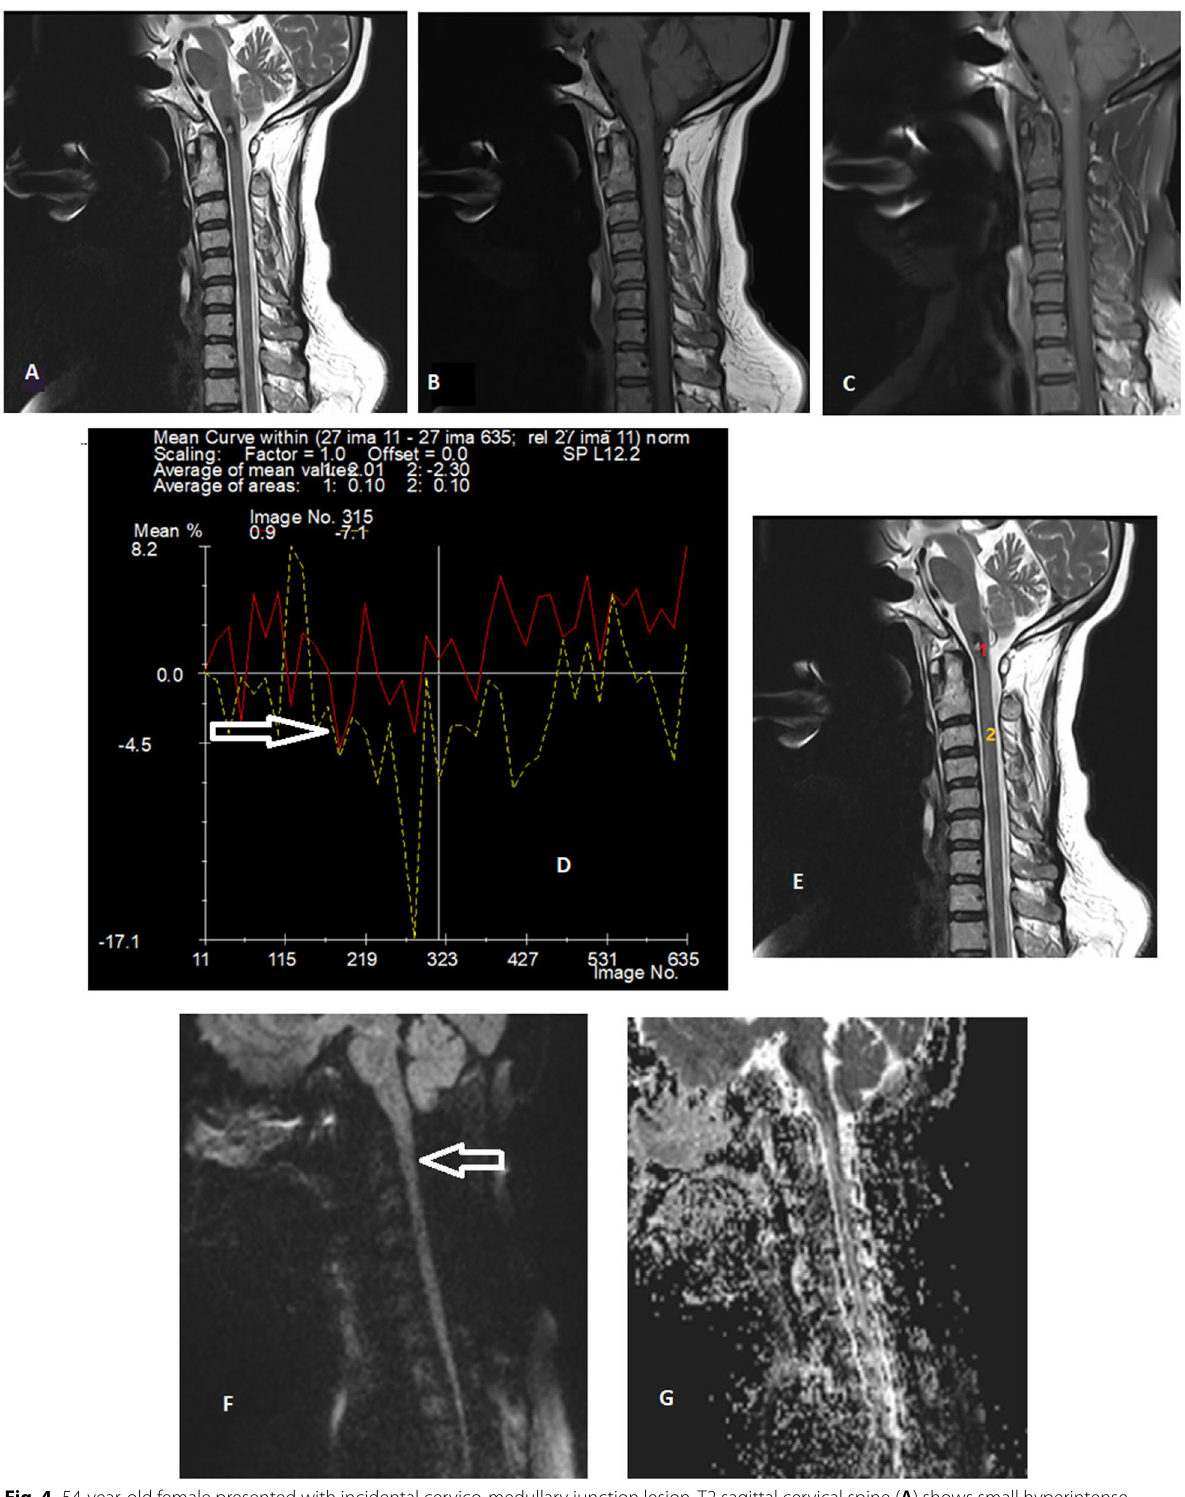
Fig. 4 54-year-old female presented with incidental cervico-medullary junction lesion. T2 sagittal cervical spine ( A ) shows small hyperintense lesion at cervico-medullary junction with peripheral hypointense rim. Pre-contrast T1 ( B ) and post-contrast T1 ( C ) show isointense lesion with no significant post-contrast enhancement. D and E rCBV was calculated in comparison to normal cord (yellow curve) and the curve shows hypo perfusion of the lesion (arrow to red curve). DWI at b value 1000 ( F ) shows no areas of high signal intensity at site of lesion (arrow) which appears = also at ADC map ( G ) denoting free diffusion. This lesion was diagnosed as